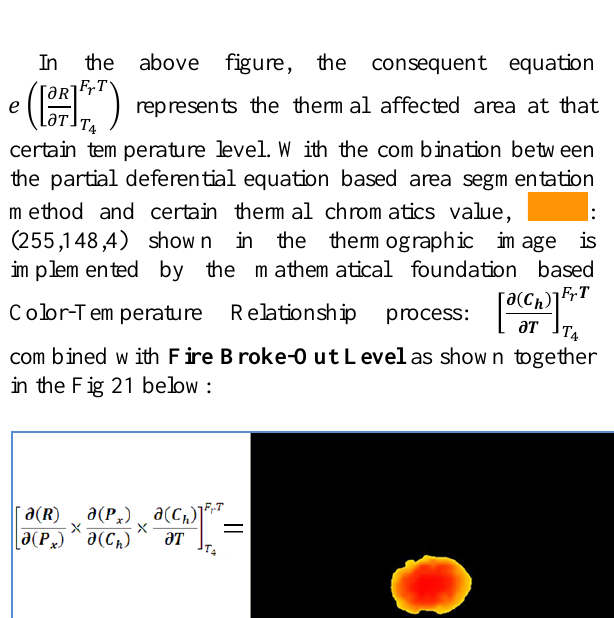
Figure 21. Chromatics value for fire ignition level with canonical